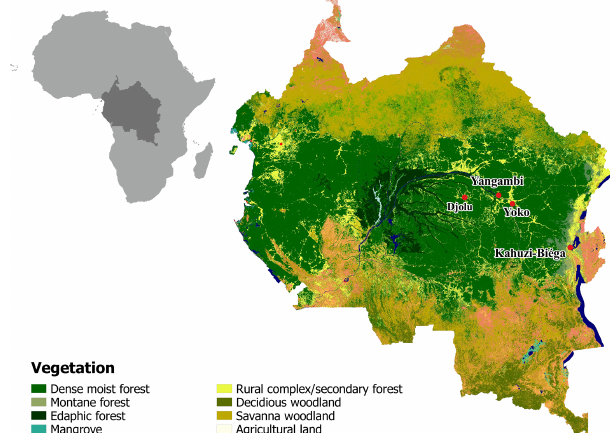
Figure 1. Map of part of the Congo Basin with the different vege- tation types. Red dots indicate sampling locations. Lowland: Djolu, Yangambi, and Yoko. Montane: Kahuzi-Biéga. Map modified based on Verhegghen et al.